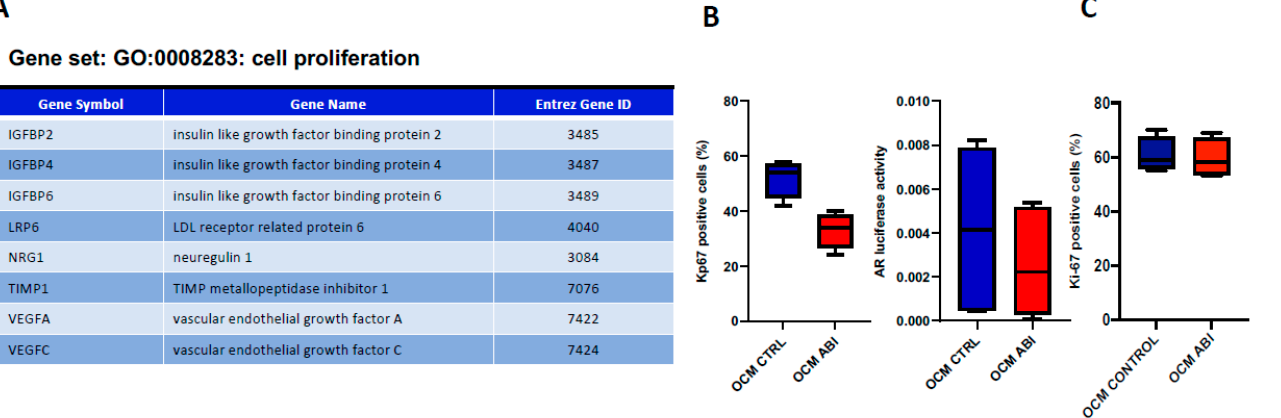
Figure 2. ( A ). Soluble molecules down-modulated in OCM ABI and associated with gene set “GO:0008283: cell proliferation” ( B ). Proliferation analysis and AR activation status in C4-2B FR treated with OCM ABI or OCM CTRL. ( C ) Proliferation analysis in PC-3 cells treated with OCM ABI or OCM CTRL.